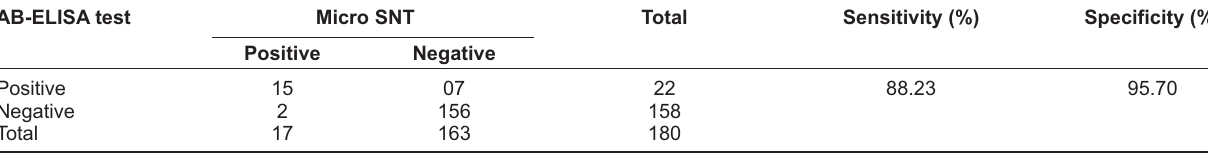
Table-2: Comparison of AB ELISA with Micro SNT on cattle serum samples. AB-ELISA